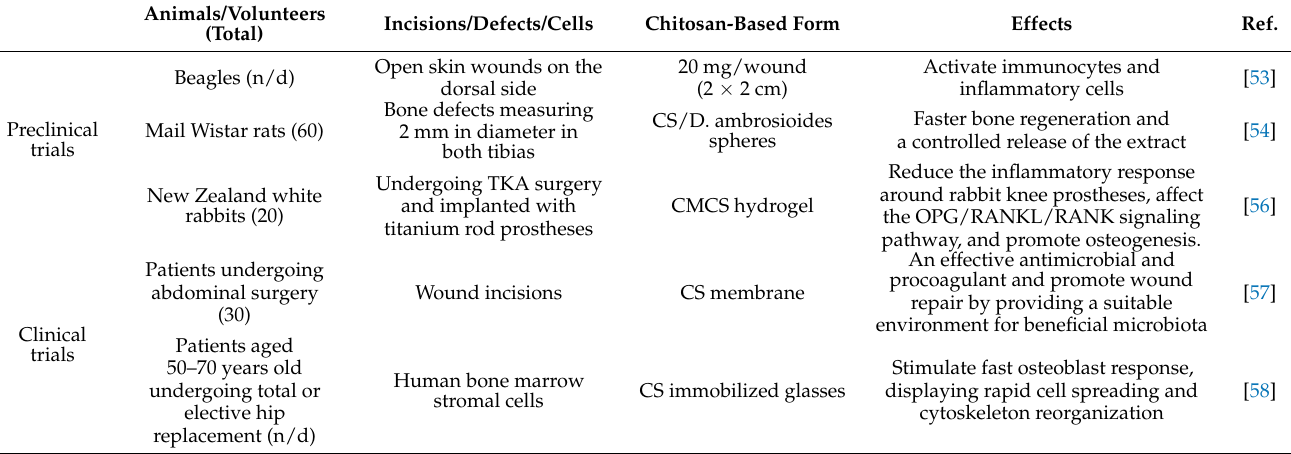
Table 2. Overview of CS-based biomaterials in preclinical and clinical